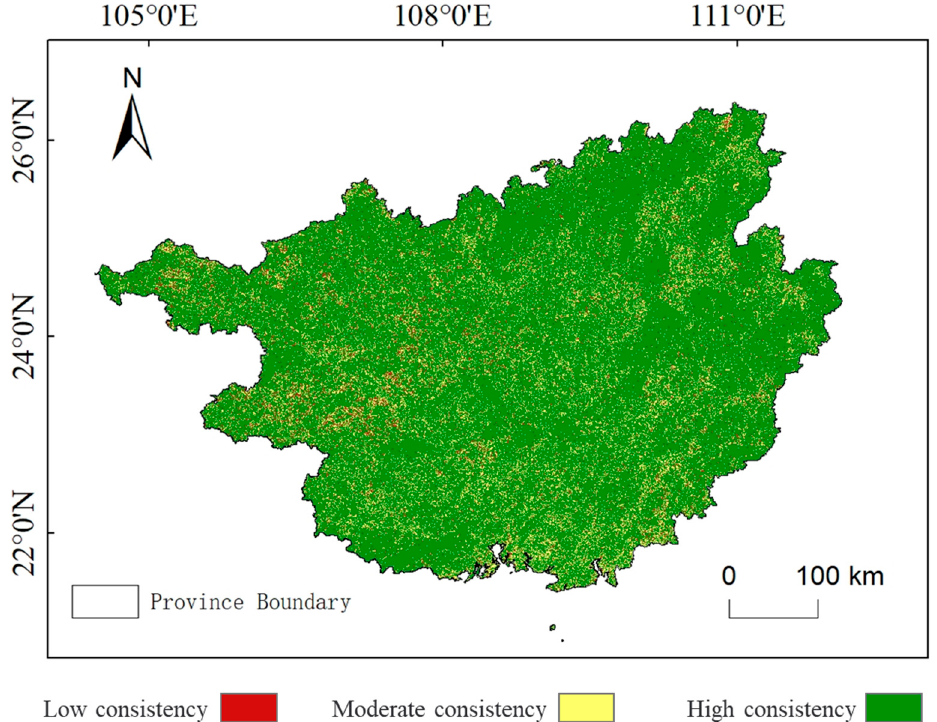
Figure 12. Map showing the degree of spatial consistency between the six land cover data products in the study area.